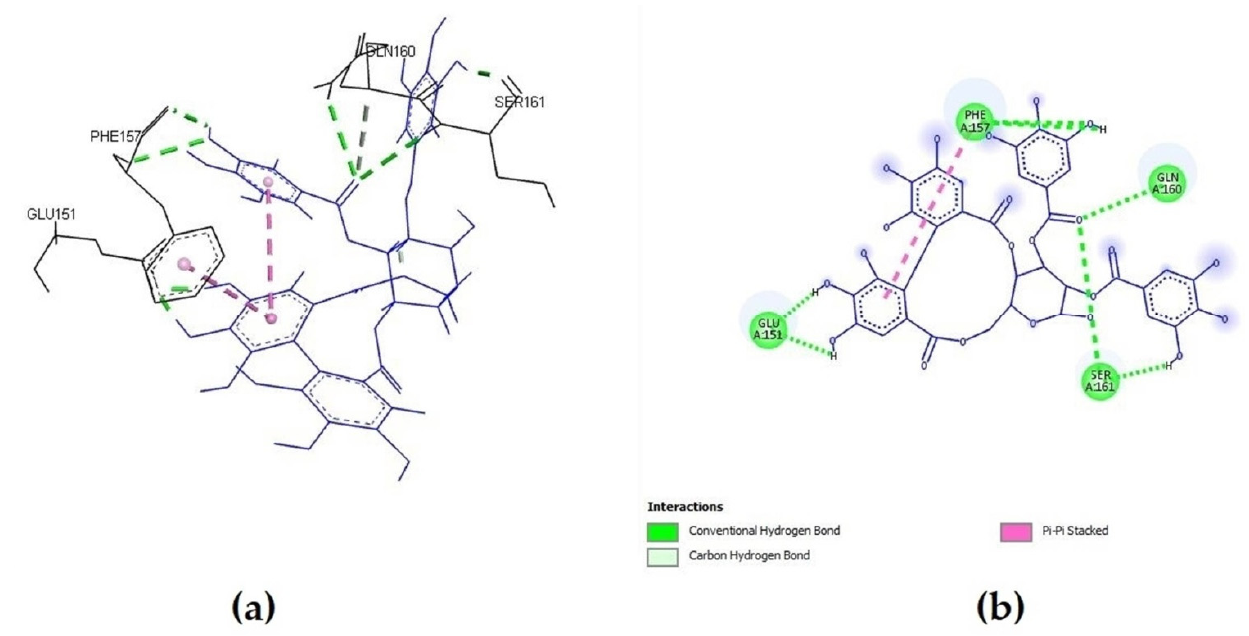
Figure 3. Tellimagrandin I interactions with S-glycoprotein (wild): ( a ) the most favorable binding pose of the compound; ( b ) 2D illustration of interaction types between the compound and target residues.